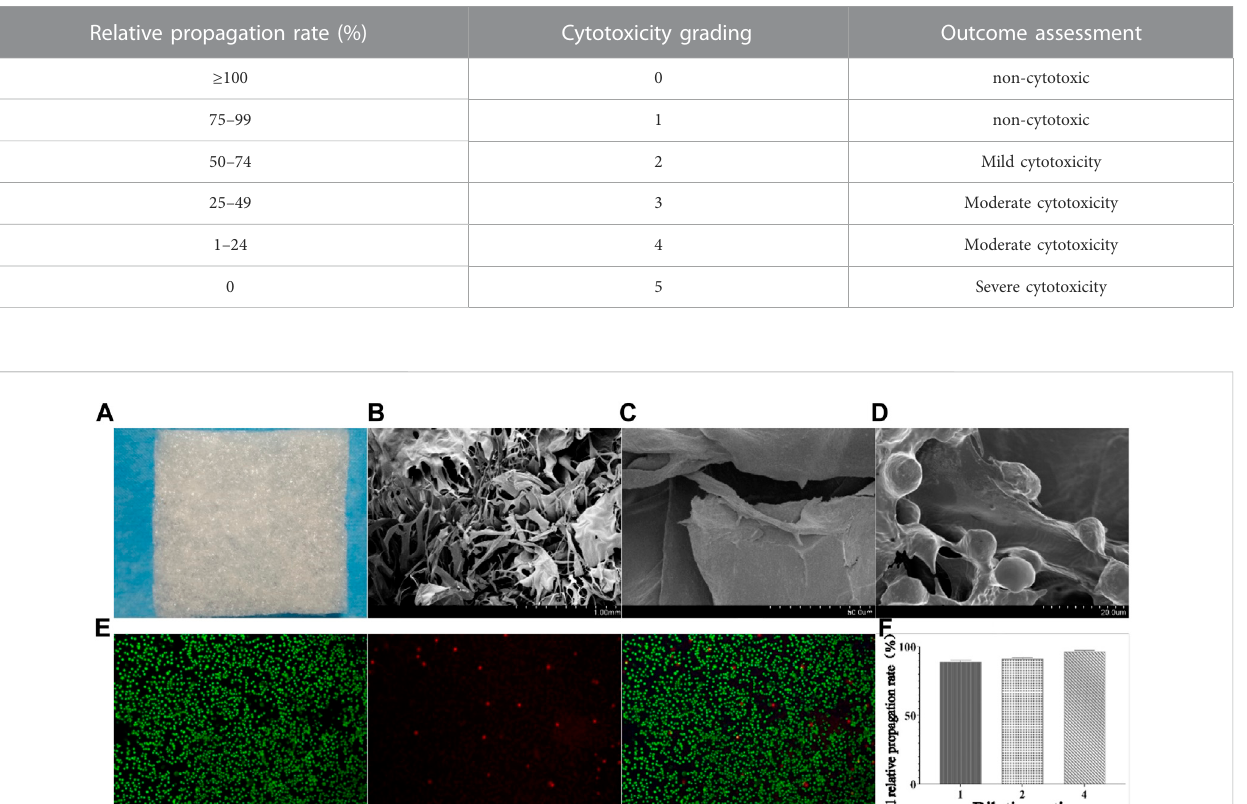
TABLE 4 Cytotoxicity evaluation grading (Wang et al., 2022).